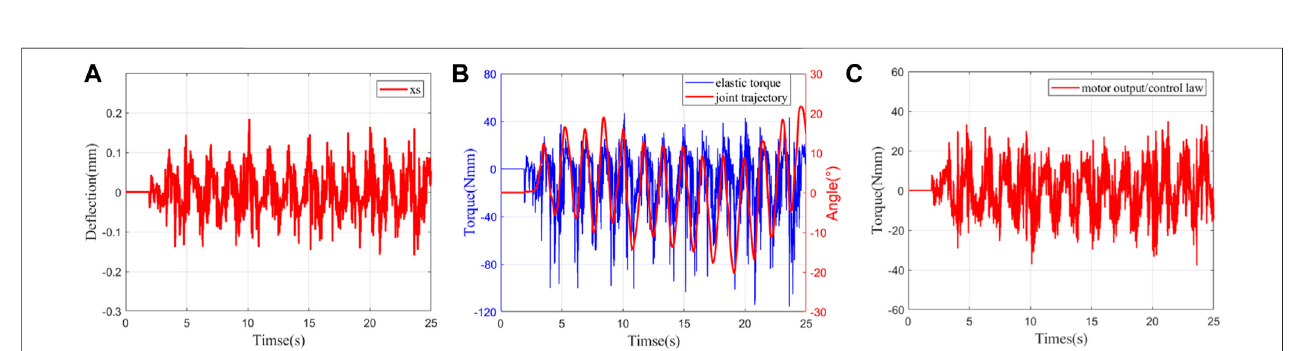
FIGURE 7 | Wearing experiment results. (A) De fl ection trajectory tracking. (B) Elastic torque and joint trajectory. (C) Motor output/control